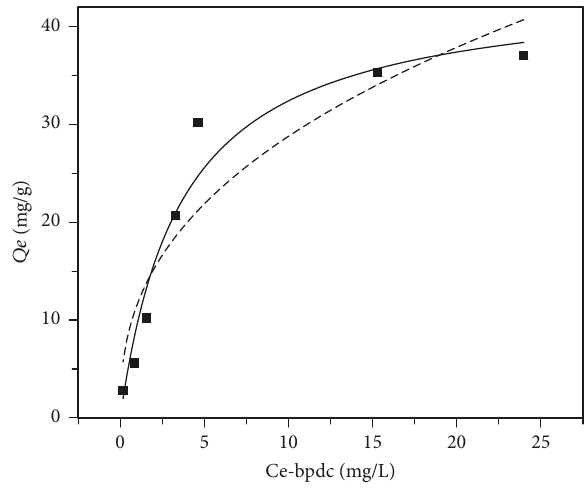
Figure 5: Equilibrium adsorption curve (conditions: adsorption time, 24 h; initial concentration of solution, 6–60mg/L; amount of adsorbent, 1.0 g/L; pH = 5-6). The solid line is Langmuir model simulation, and the dashed line is Freundlich model simulation.